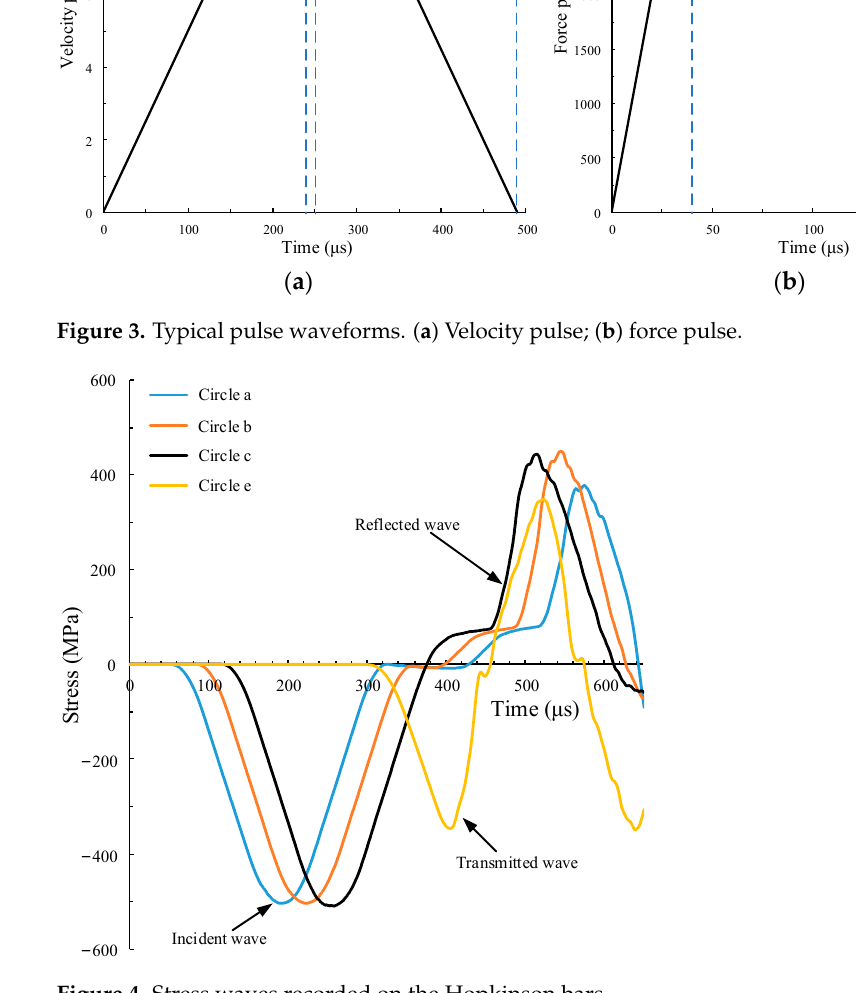
Figure 3. Typical pulse waveforms. ( a ) Velocity pulse; ( b ) force pulse